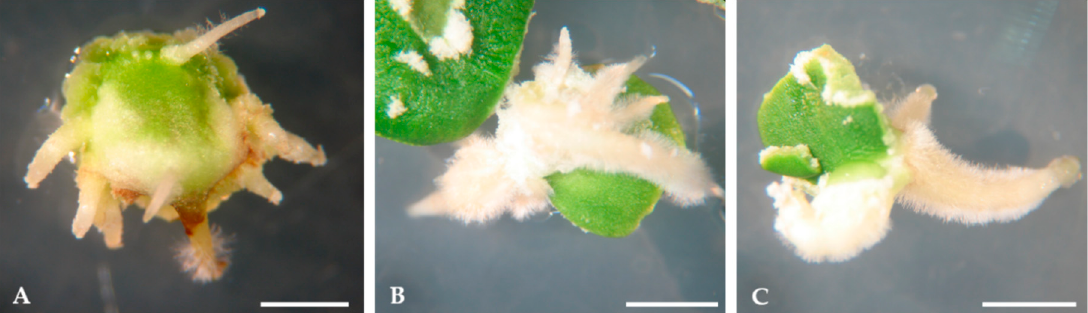
Figure 3. Neo-formation of roots during the induction phase. ( A ) Evolution from radicles, ( B ) from the proximal region of cotyledons, and ( C ) from the distal region of cotyledons. Bars: 5 mm.